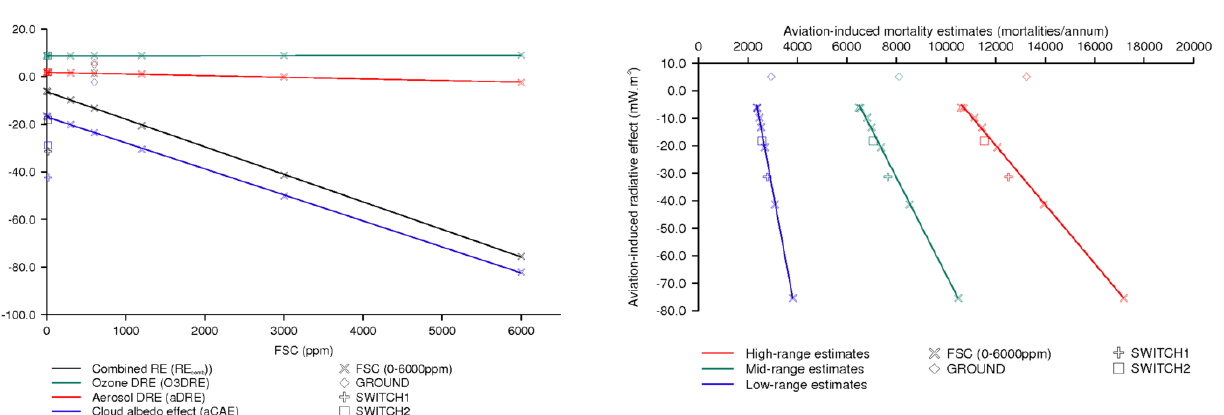
Figure 9. Aviation-induced radiative effects due to variations in fuel sulfur content (FSC), the ground release of aviation emissions (GROUND), and variations in the vertical distribution of aviation SO 2 emissions (SWITCH1 and SWITCH2 simulations).